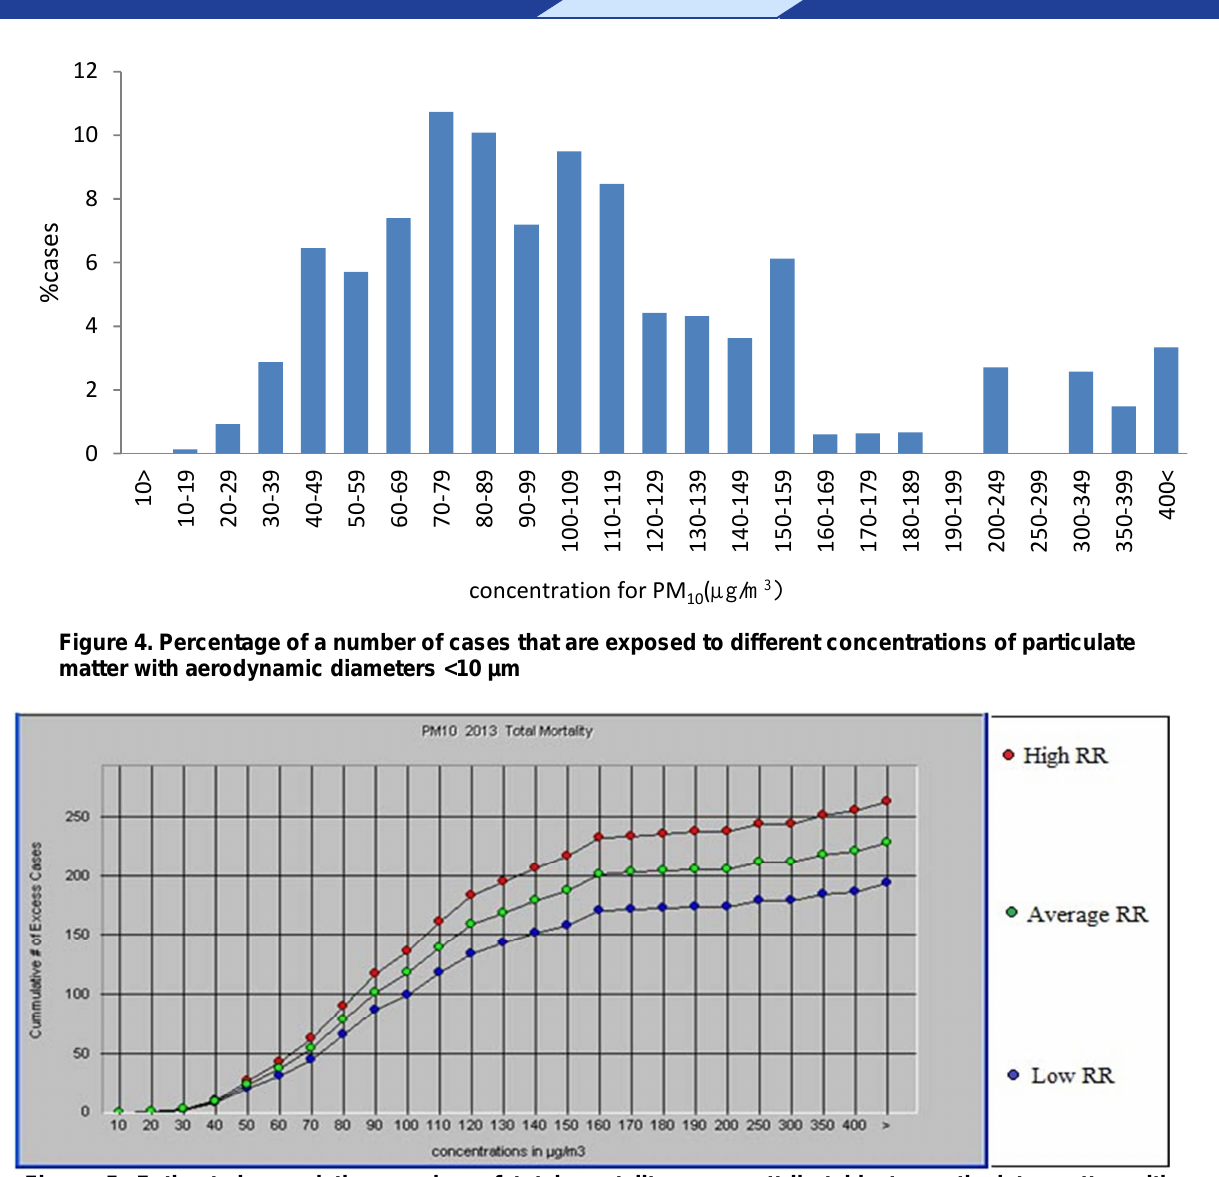
Figure 5. Estimated cumulative number of total mortality cases attributable to particulate matter with aerodynamic diameters <10 µm comparing concentration intervals by means of the model (Sanandaj, Iran,